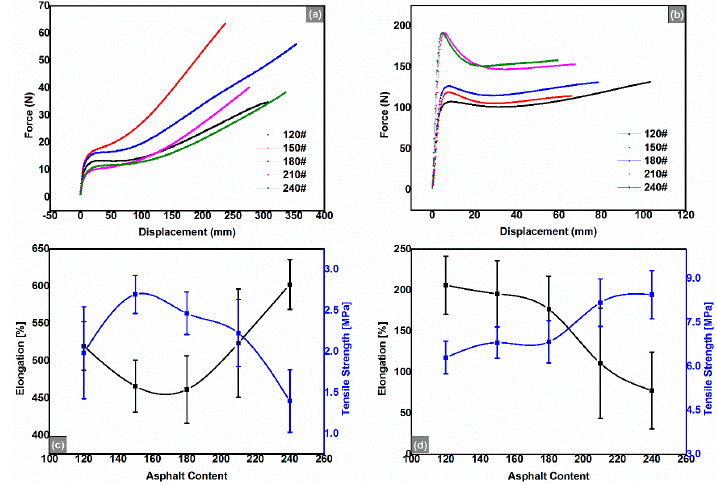
Figure 2. Force vs. displacement of the anhydrides-cured bimodal REACs at 20 °C ( a ) and at 0 °C ( b ); Tensile strength and rupture elongation vs. asphalt content at 20 °C ( c ) and 0 °C ( d ).